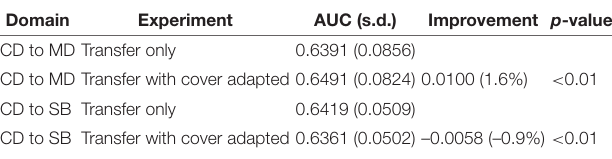
TABLE 5 | Adapted model vs. transferred model.